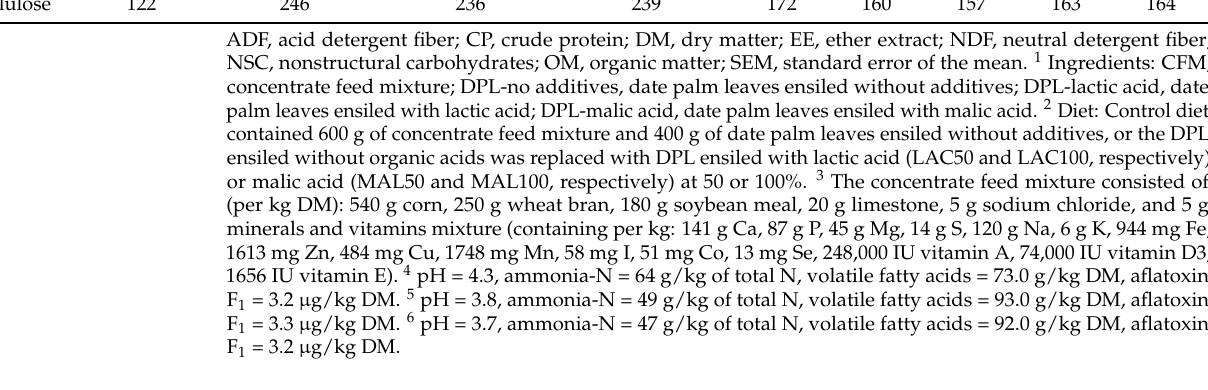
minerals and vitamins mixture (containing per kg: 141 g Ca, 87 g P, 45 g Mg, 14 g S, 120 g Na, 6 g K, 944 mg Fe, 1613 mg Zn, 484 mg Cu, 1748 mg Mn, 58 mg I, 51 mg Co, 13 mg Se, 248,000 IU vitamin A, 74,000 IU vitamin D3, 1656 IU vitamin E). 4 pH = 4.3, ammonia-N = 64 g/kg of total N, volatile fatty acids = 73.0 g/kg DM, aflatoxin